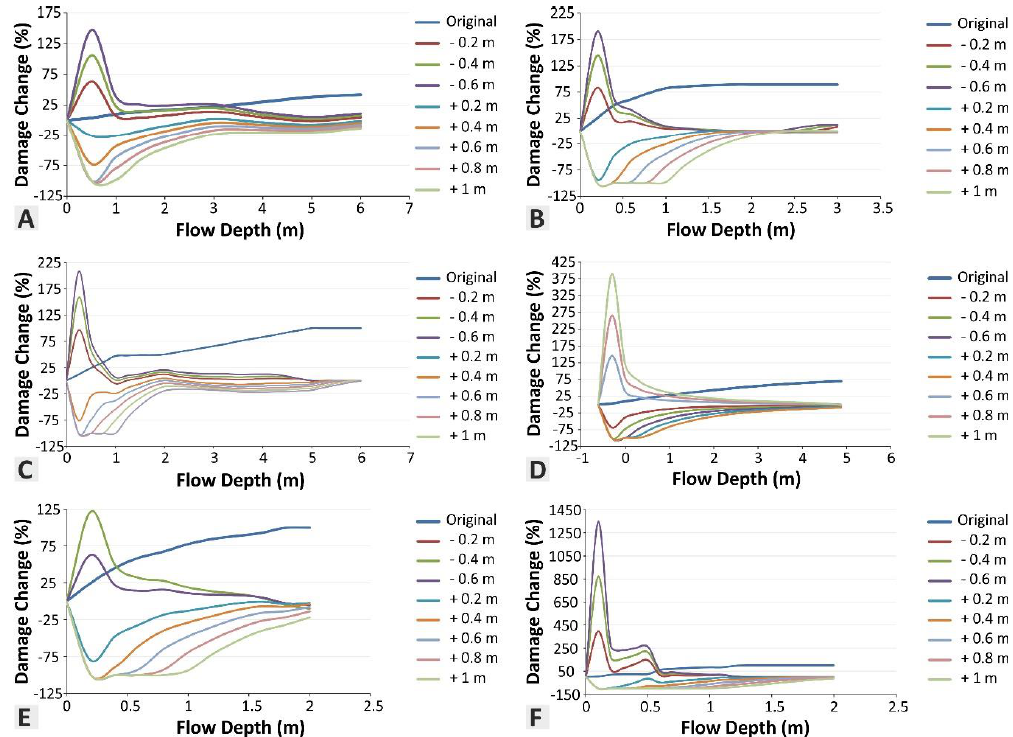
Figure 5. River flooding economic damage change (%) by considering topographic over– and under– elevation of buildings from magnitude–damage models of the Czech Republic (A), Australia–Content (B), HKV–Content (C), USA–Type IV–Content (D), Pajares de Pedraza–V2P (E) and Pollo Ravine– Type II (F).